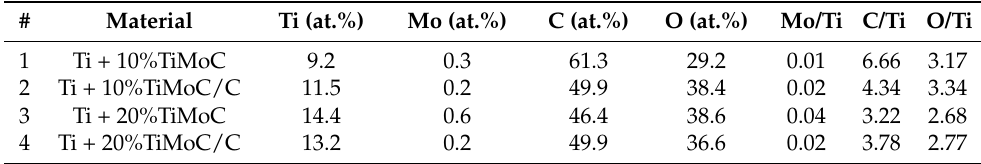
Table 5. Chemical composition of the passive